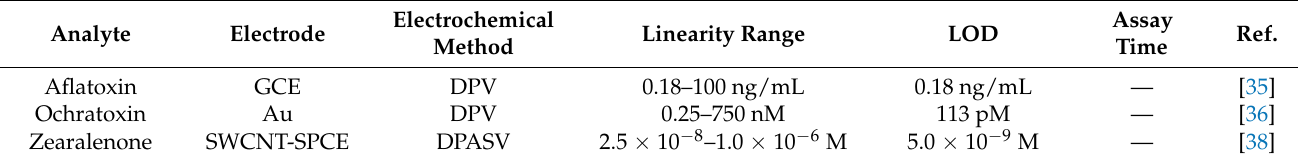
Table 3. Electrochemical biosensors for mold detection.